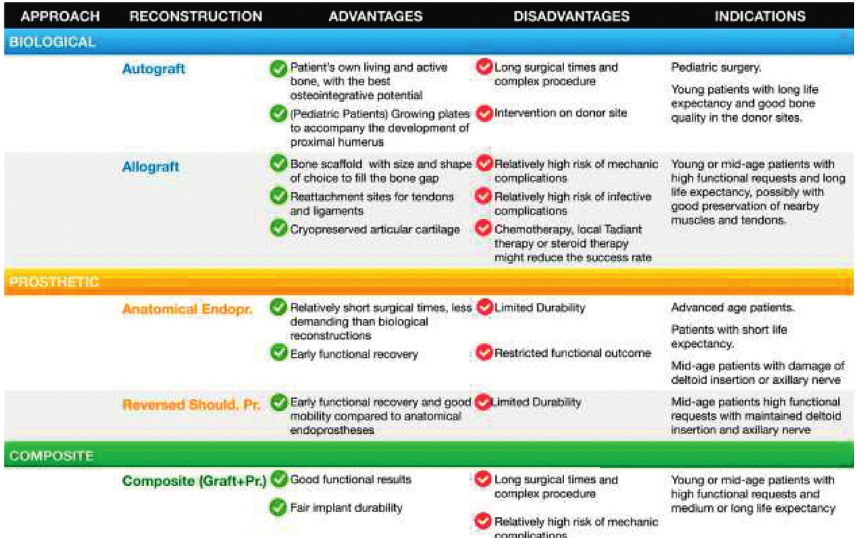
Figure 4: Schematic summary of the main advantages and disadvantages, with consequential indications, for the main reconstructive approaches to proximal humerus in oncologic